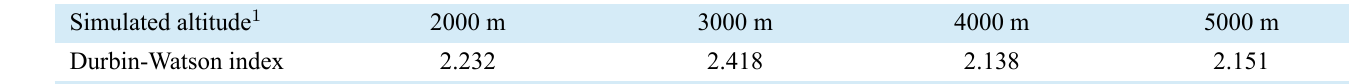
FIGURE 1. Scatter plot. PWC: physical work capacity. TABLE 8. Durbin-Watson index.